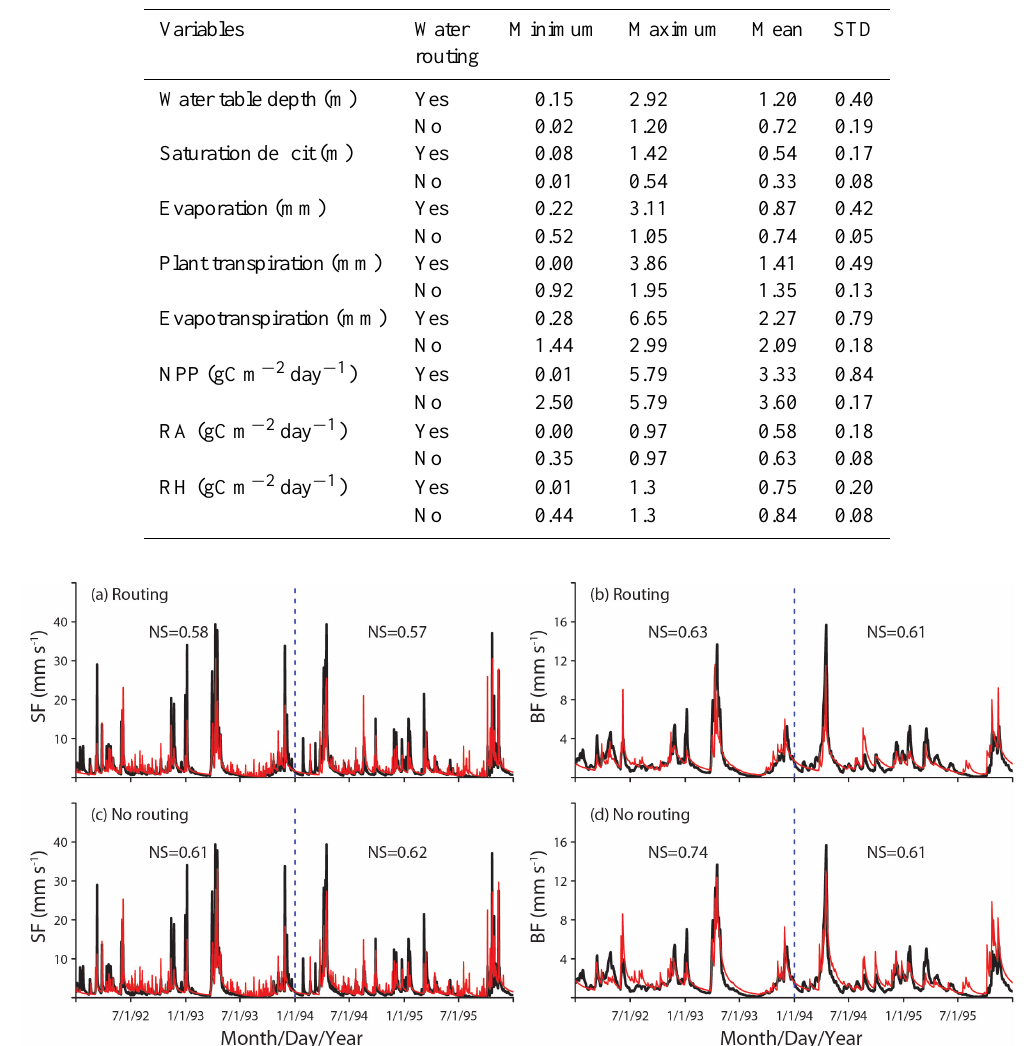
Fig. 2. Calibration (for the period 1 January 1992–31 December 1993) and evaluation (for the period 1 January 1994–31 December 1995) of R-RHESSys simulated daily streamflow (SF) and baseflow (BF) (solid red line) against observed/derived data (solid black line). Simulations in (a) and (b) considered water routing while simulations in (c) and (d) ignored water routing. NS is short for the Nash–Sutcliff coefficient. The blue-dashed line represents 1 January